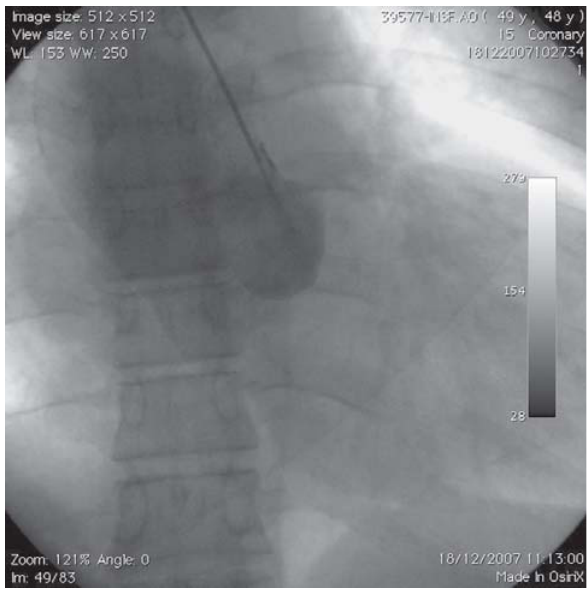
Fig. 1 - Aortografia demonstrando alargamento de aorta